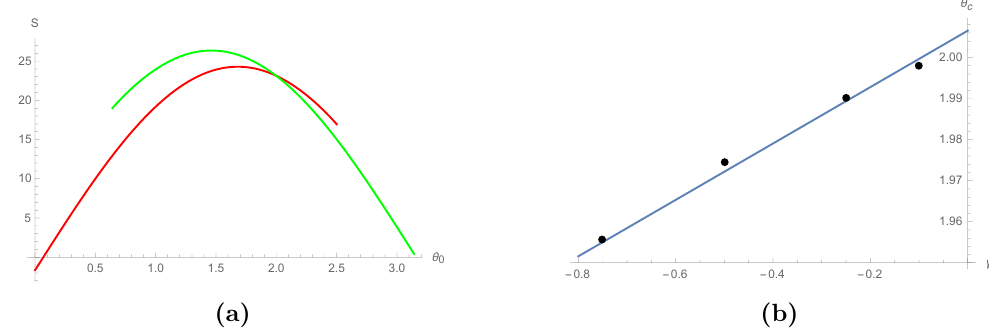
Figure 3. d = 4. a) shows the Wald entropy for the connected (red) and disconnected (green) surfaces as a function of the boundary region (cid:18) 0 . We have used g = (cid:12) = G = 1, (cid:13) = (cid:0) 0 : 1 and (cid:22) = 2 : 711055. b) Critical angle (cid:18) c versus (cid:13) , with g = (cid:22) = (cid:12) =